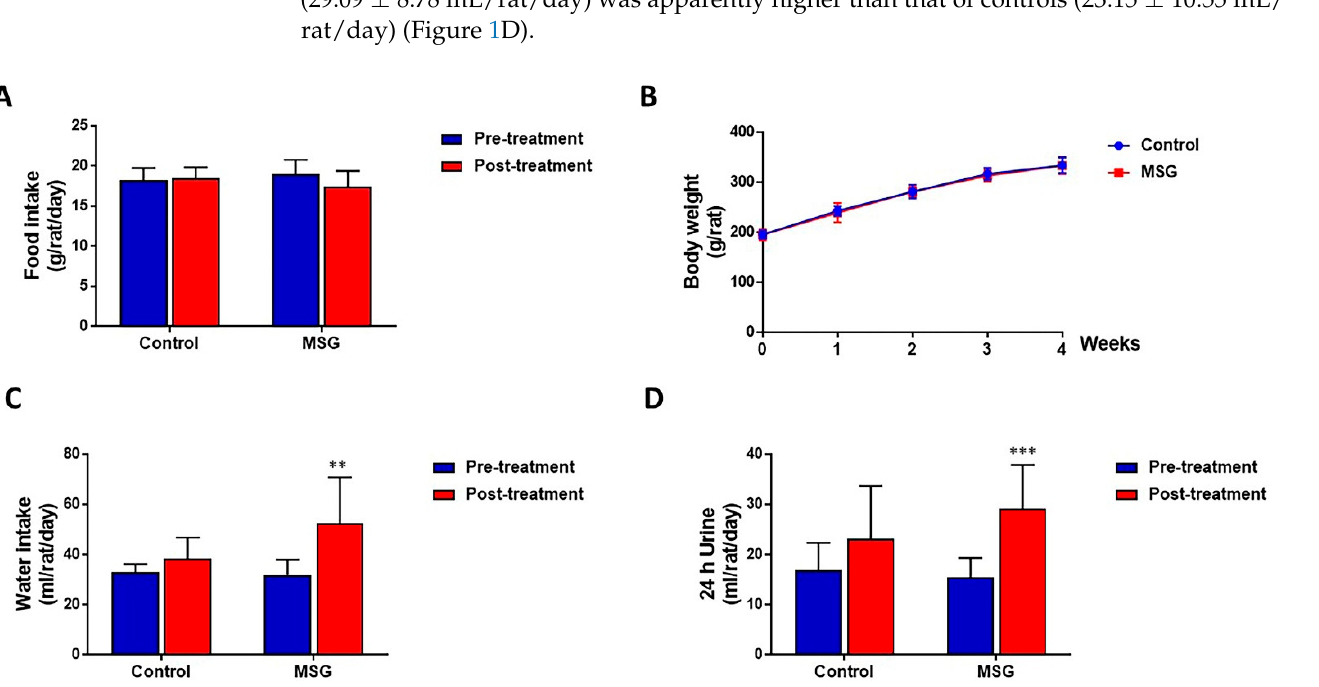
Figure 1. ( A ) Food intake ( B ) Body weight ( C ) Water intake and ( D ) Urine output of male Wistar rats supplemented with 1 g% MSG and control animals (n = 10 per group) at baseline and at 2 weeks. Data are shown as mean ± SD and p -values calculated by Student’s t -test, ** p < 0.01, *** p < 0.001).